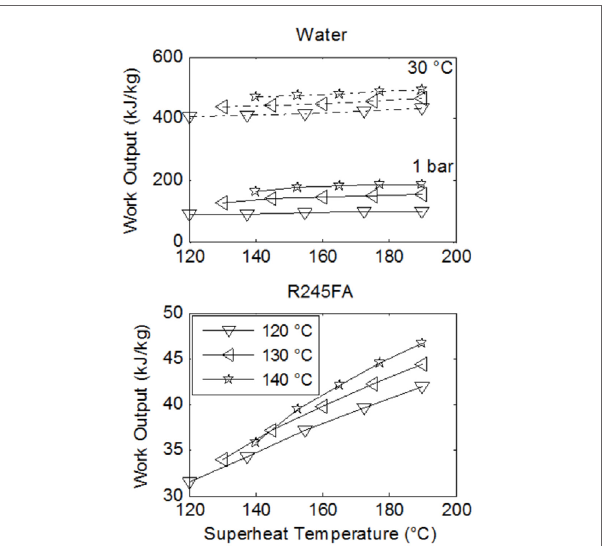
FiGURe 5 | Comparison of specific work output, or power output per unit working fluid mass flow rate, from Rankine cycles with water and R-245fa over a range of maximum cycle temperatures, T 3 , which from Figure 3 are found between the evaporator and the expander . The heat-source fluid stream has an initial temperature T hot,in = 200°C, a mass flow rate  m kg/s = 500 and a specific heat capacity c p,hot = 1 kJ/kg K. The hot three lines correspond to different evaporation (saturation) temperatures, given in the legend. Water results are shown for expansion down to (and condensation at) 1 bar/100°C and 0.04 bar/30°C.